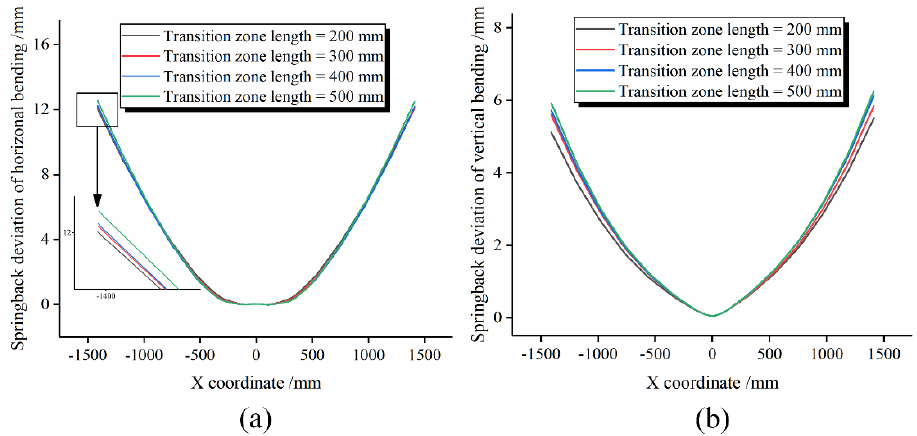
Figure 9. Springback deviation with different transition zone lengths. ( a ) Springback deviation of horizonal bending. ( b ) Springback deviation of vertical bending.